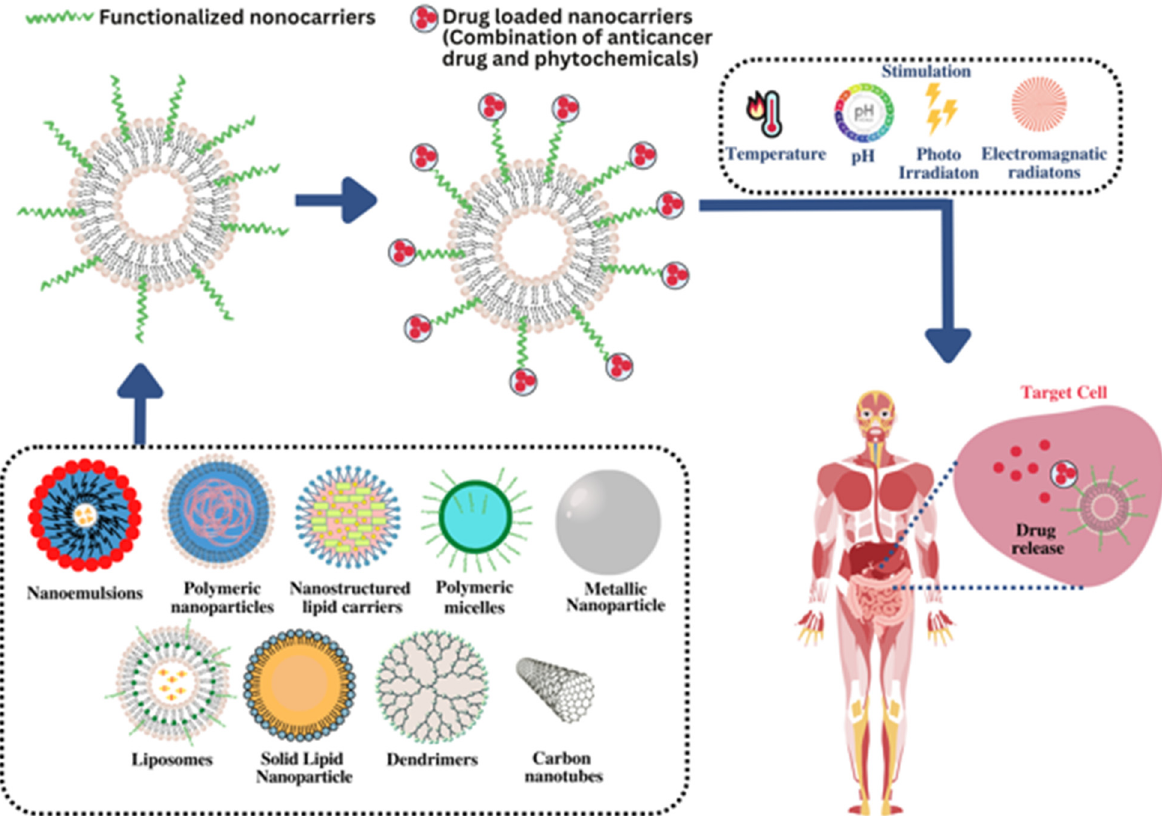
Figure 6. Mechanism of various nanocarriers to target the drug at the cancer